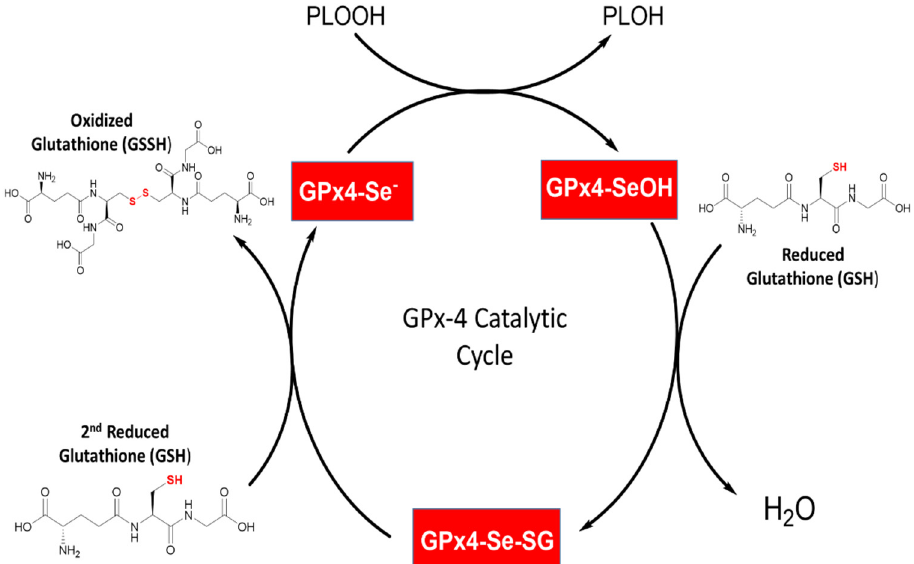
Figure 4. GPX4 catalytic cycle representation. GPX4 selenol (GPX4-SeH) gets oxidized into selenic acid (GPX4-SeOH). This oxidation powers the reduction of toxic lipid hydroperoxides into their respective alcohol. The selenic acid is reduced back to its active form selenol using two equivalents of GSH. The first equivalent of GSH reacts with selenic acid to form a selenium-glutathione intermediate and generate water. While the second GSH equivalent reacts to reduce the selenium-glutathione intermediate into a selenol together with the release of glutathione disulfide (GSSG).